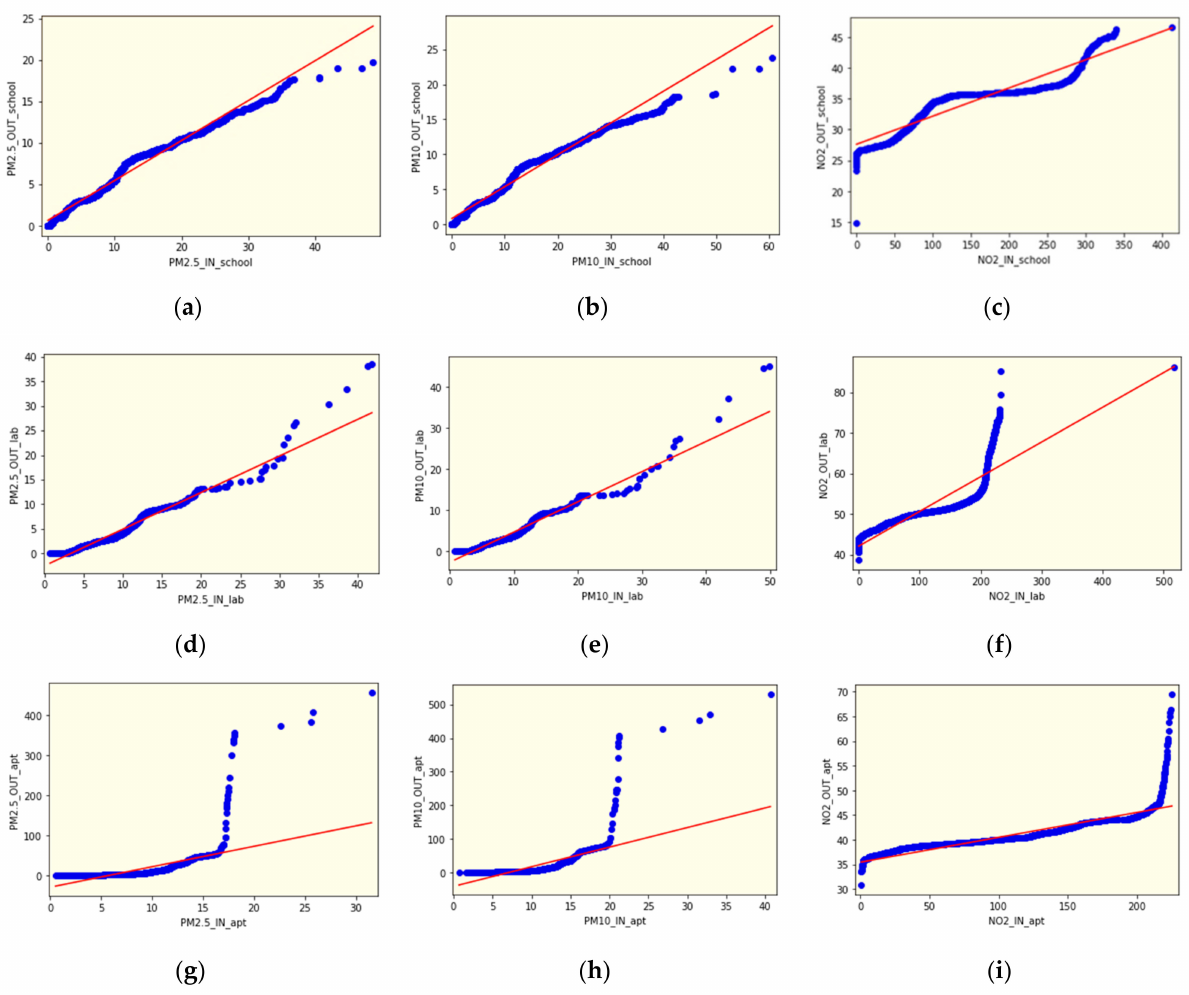
Figure 3. Quantile-Quantile (Q-Q) plot of indoor-outdoor data: ( a ) Site 1-PM 2.5 , ( b ) Site 1-PM 10 , ( c ) Site 1-NO 2 , ( d ) Site 2-PM 2.5 , ( e ) Site 2-PM 10 , ( f ) Site 2-NO 2 , ( g ) Site 3-PM 2.5 , ( h ) Site 3-PM 10 , ( i ) Site 3-NO 2 . With an identity line ( y = x , which acts as reference to standardize the